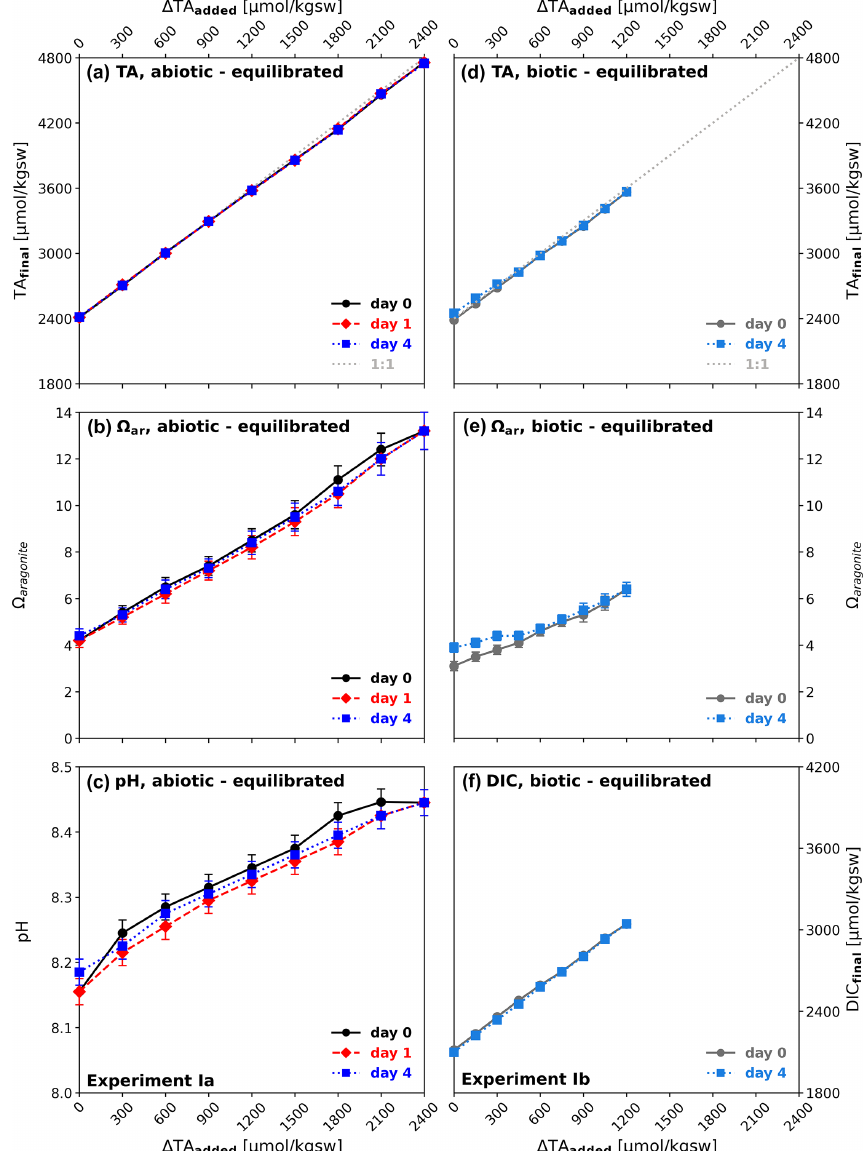
Figure 1. Temporal development after CO 2 -equilibrated alkalinization: (a, b, c) experiment Ia, (d, e, f) experiment Ib; (a, d) (cid:49) TA added vs. TA final ; (b, e) aragonite saturation state ( (cid:127) aragonite ) in relation to (cid:49) TA added ; (c) pH in relation to (cid:49) TA added ; (f) DIC final in relation to (cid:49) TA added . Black/grey symbols correspond to start of the experiment, red after 1d, and blue after 4d. TA initial conditions of used seawater: (cid:49) TA 0 ≈ 2411µmolkgsw − 1 , (cid:127) Ar = 4 . 2, pH = 8.15. caused strong changes in the carbonate system with (cid:127) aragonite tion only occurred at and above (cid:49) TA 1500 , with no detectable values above 20 for (cid:49) TA 1500 to (cid:49) TA 2400 and between 15 precipitation at (cid:49) TA 900 and (cid:49) TA 1200 (starting (cid:127) aragonite 16 and 17 for (cid:49) TA 1050 to (cid:49) TA 1200 , i.e. well above the criti- and 19, Fig. 2e). The loss ratio in TA : DIC was about 2 : 1 cal threshold. Consequently, while precipitation was absent (Fig. 3b, d) in all treatments, indicating the loss of alka- in the abiotic and biotic set-up in the equilibrated treatment, linity due to the precipitation of carbonates. Loss ratio in strong alkalinity loss through precipitation occurred in the TA : DIC for the abiotic set-up was 2.12 for (cid:49) TA 1500 , 1.98 non-equilibrated experiment. While in the biotic set-up pre- for (cid:49) TA 1800 , 2.06 for (cid:49) TA 2100 , and 2.03 for (cid:49) TA 2400 , and cipitation was observed at (cid:49) TA 1050 and (cid:49) TA 1200 (starting for the biotic set-up was 2.11 for (cid:49) TA 1050 and 2.09 for (cid:127) aragonite 15 and 17, Fig. 2b), in the abiotic set-up precipita- (cid:49) TA 1200